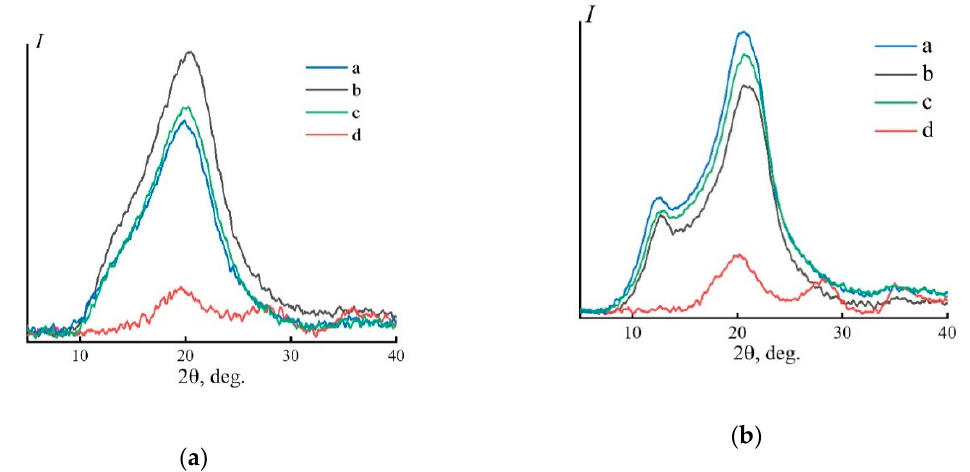
Figure 6. Equatorial (a,c) and meridional (b,d) diffraction patterns for cellulose fibers obtained through isobutanol baths (70 °C) and dried ( a ) and equatorial (a,c) and meridional (b,d) diffraction patterns for cellulose fibers obtained through isobutanol baths (70 °C), washed in water, and dried ( b ). Geometry of scanning—“reflection” (a,b) and “transmission” (c,d).